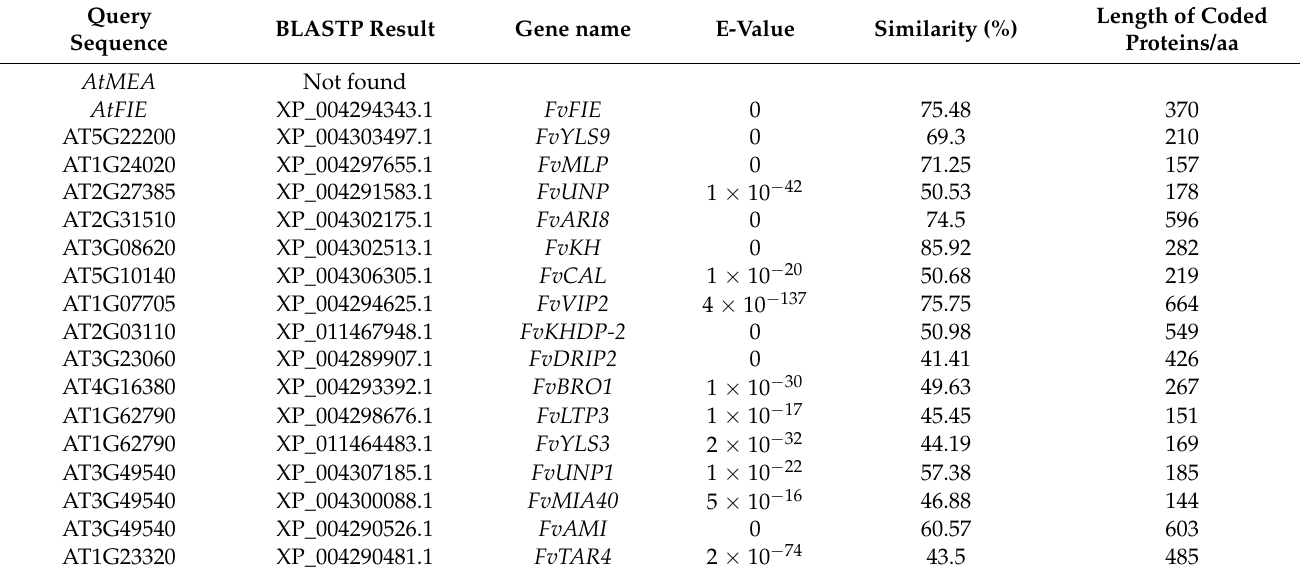
Table 1. Details of 17 candidate imprinted genes of Fragaria vesca